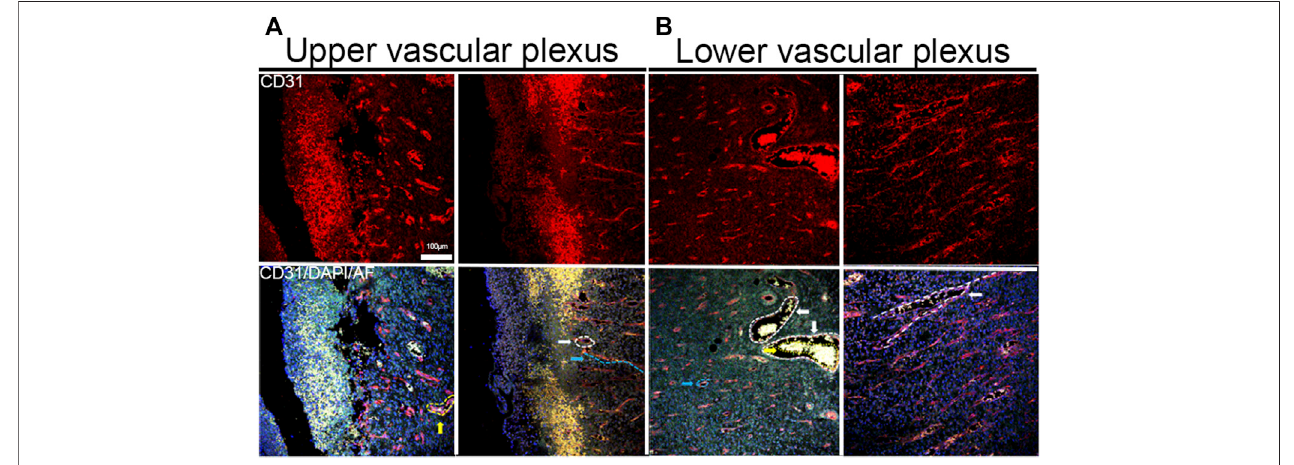
FIGURE4| IFstainingimage ofblood vessels. (A) Images ofhorizontal andverticalblood vessels inthesuper fi cialdermis (theverticalvessel wasmarkedwithblue dotted lines; the horizontal vessel section of horizontal vessels was marked with white dotted lines). (B) Horizontal and vertical blood vessels in the deep dermis (the section of horizontal vessels was marked with blue dotted lines, the sections of large horizontal vessels were marked with white dotted lines, the red blood cells were in large blood vessels, and the path of branch blood vessels was marked with white dotted lines).